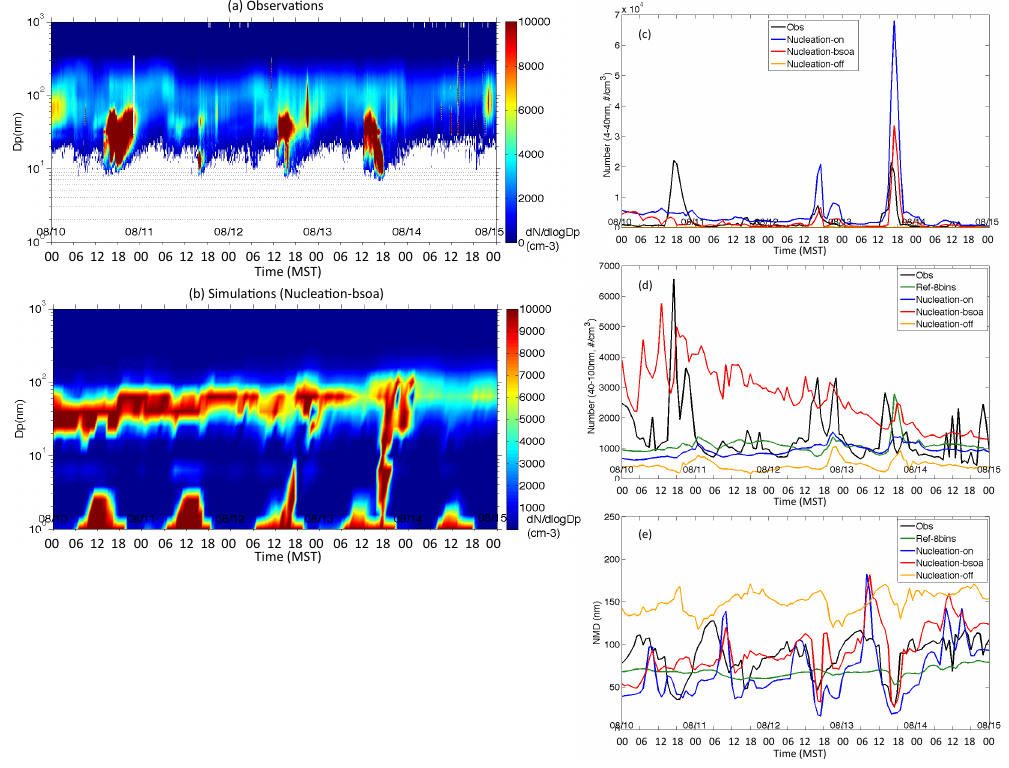
Figure 8: Similar to Figure 7 but for the August 10-14, 2011 time period. Figure 8. Similar to Fig. 7 but for the 10–14 August 2011 time